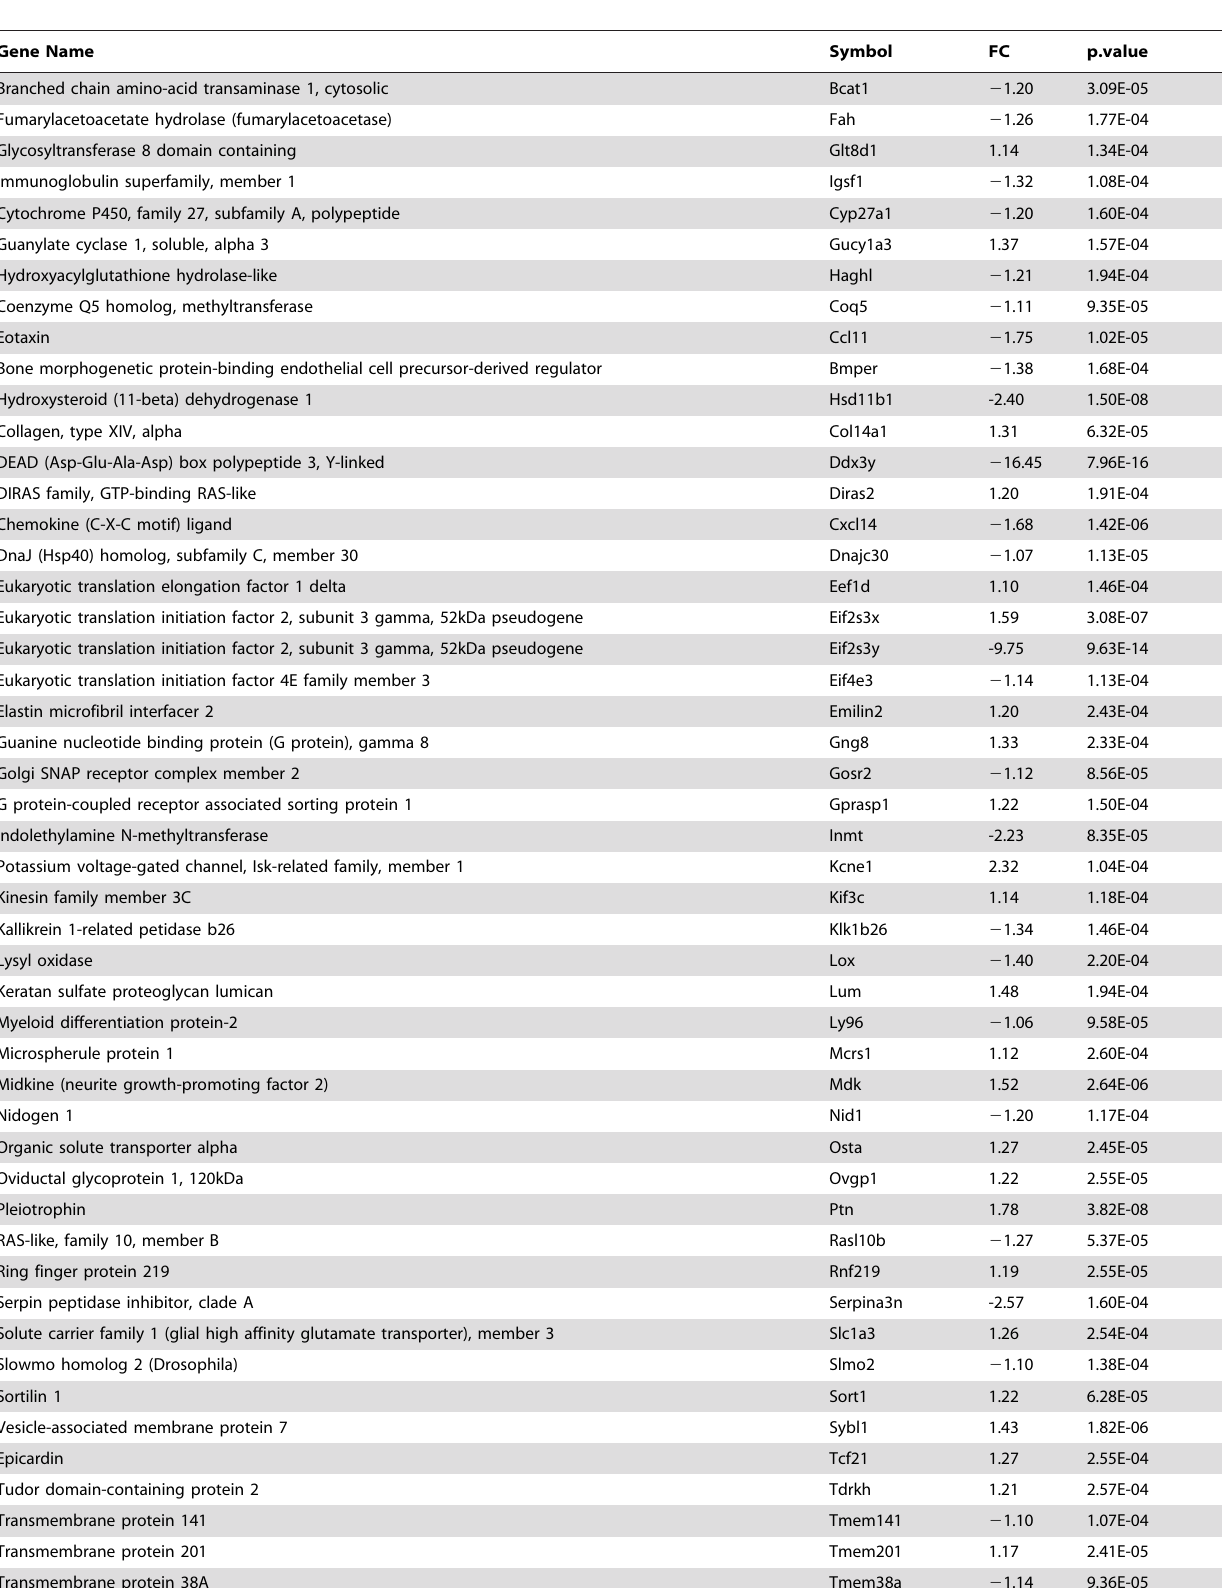
Table 3. List of significant, differentially expressed genes, attributed to sex (P , 0.05, 2-Way ANOVA) between cs-ER a 2 / 2 and Wild type